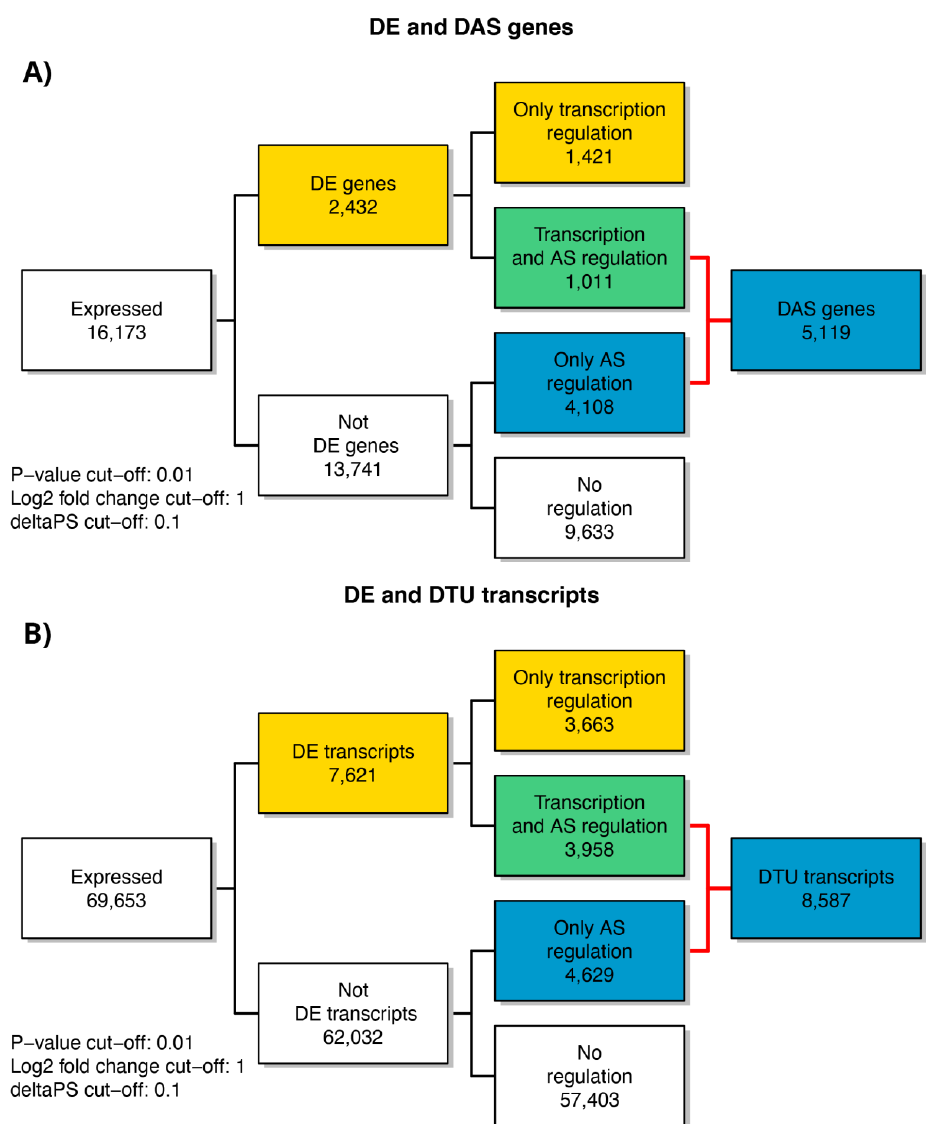
Figure 2. Summary figure of expressed genes and significant DE, DE + DAS, DE + DTU, DAS and DTU genes from analysis of the considered time points of RPE cell data. ( A ) Number of genes regulated only by transcription (DE), only by alternative splicing (DAS) and by both transcription and alternative splicing (DE + DAS); ( B ) number of transcripts regulated only by transcription (DE), only by alternative splicing (DAS) and by both transcription and alternative splicing (DE + DAS). DTU = Differential Transcript Usage. AS = Alternative Splicing.